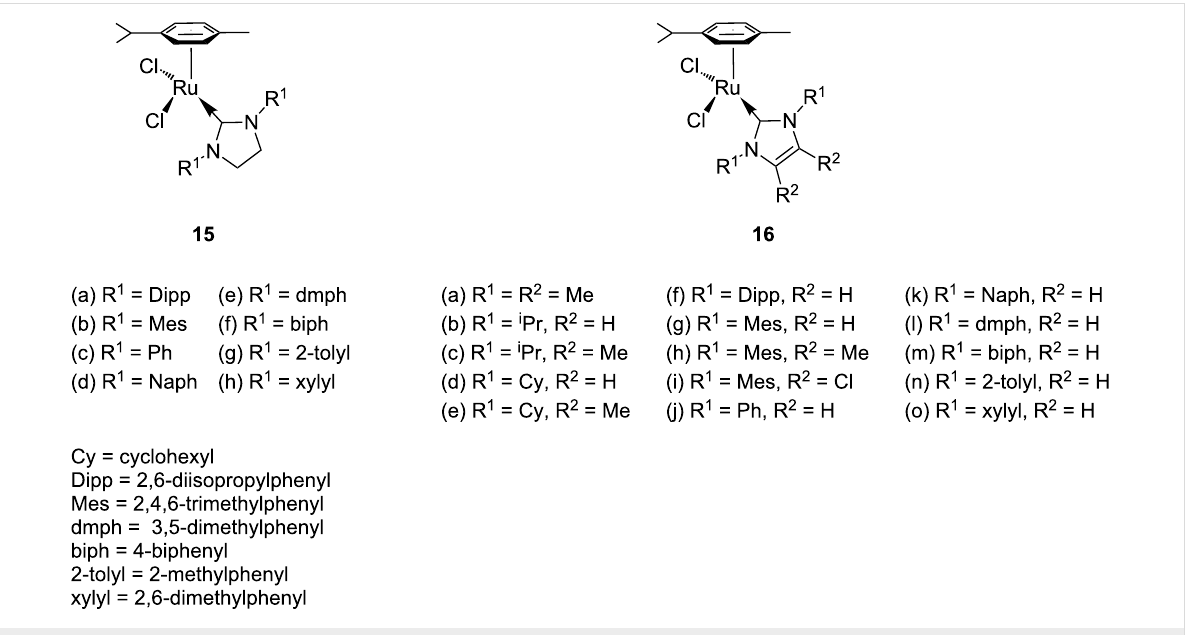
Figure 8: Ruthenium complexes with p -cymene and NHC ligands.